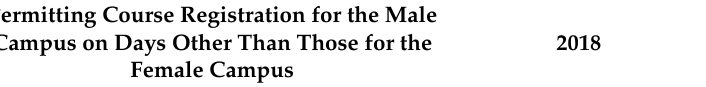
Table 9. Distribution of student numbers according to their feedback on allowing course registra- tion for the male campus on days other than those for the female campus in 2018 and 2020.